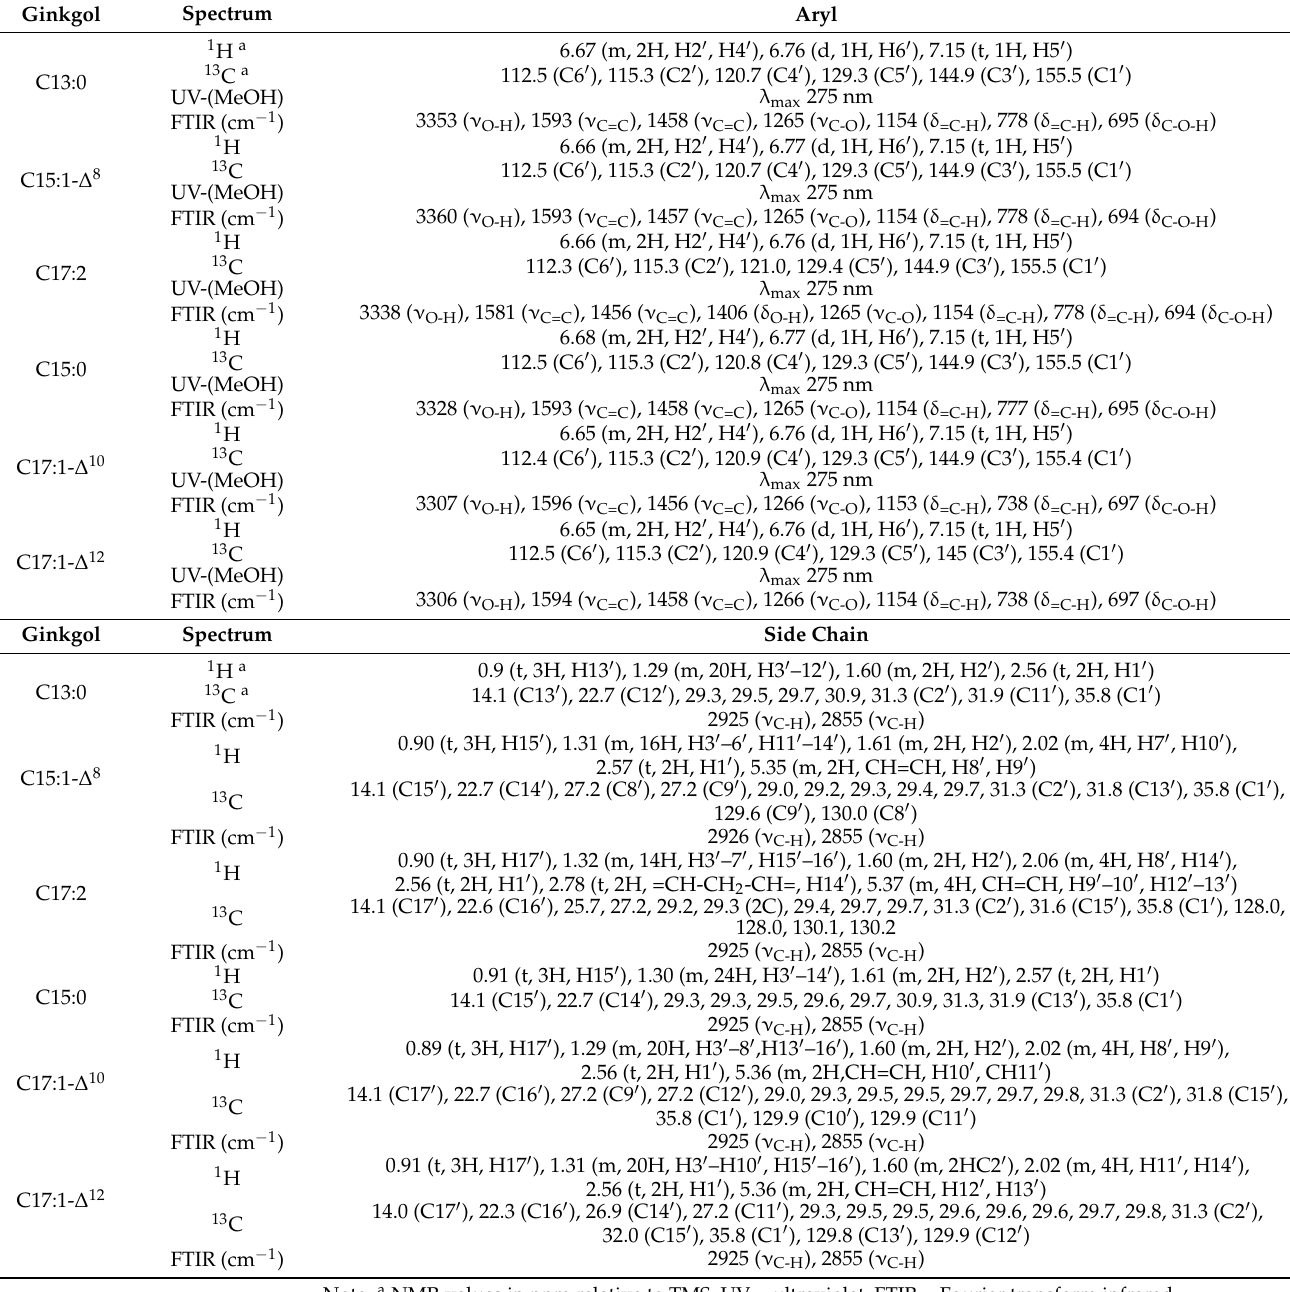
Table 2. 1 H-NMR, 13 C-NMR, UV, and FTIR spectra of isolated ginkgol